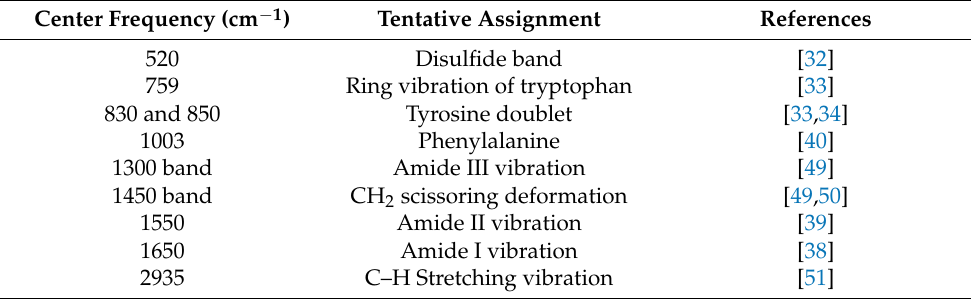
Table 2. Tentative assignment of the main vibrational bands obtained from sera